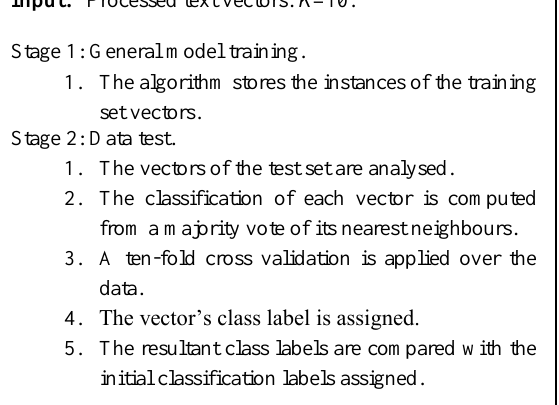
Algorithm 3. KNN data classification